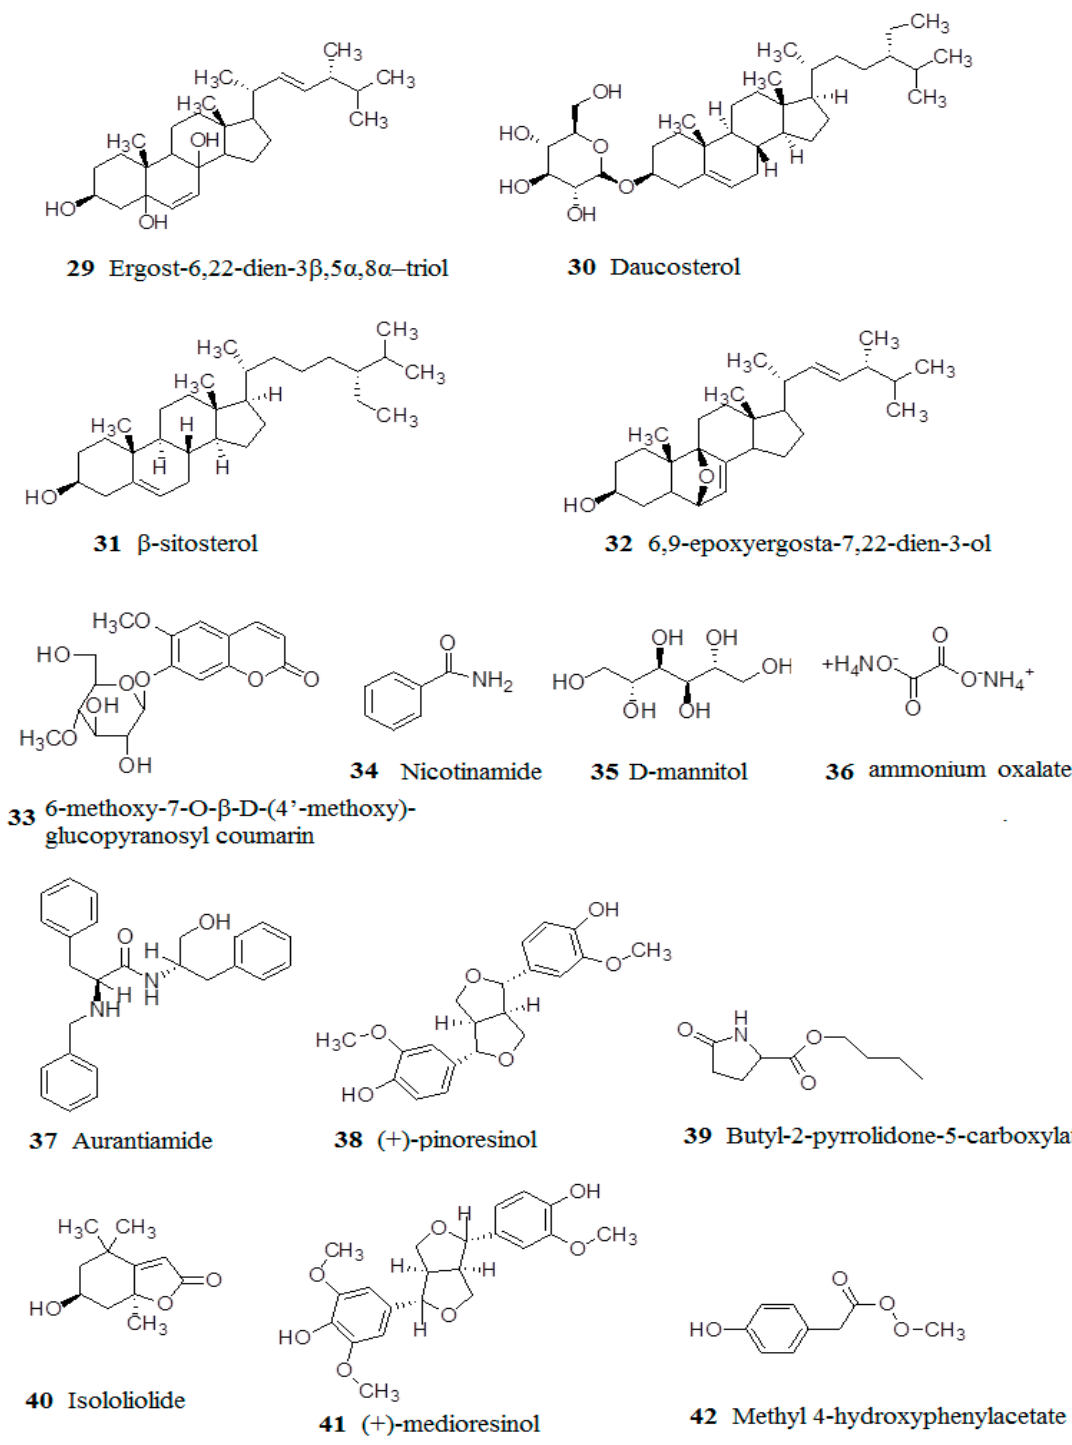
Figure 2. Chemical structures of compounds isolated from B. batryticatus .